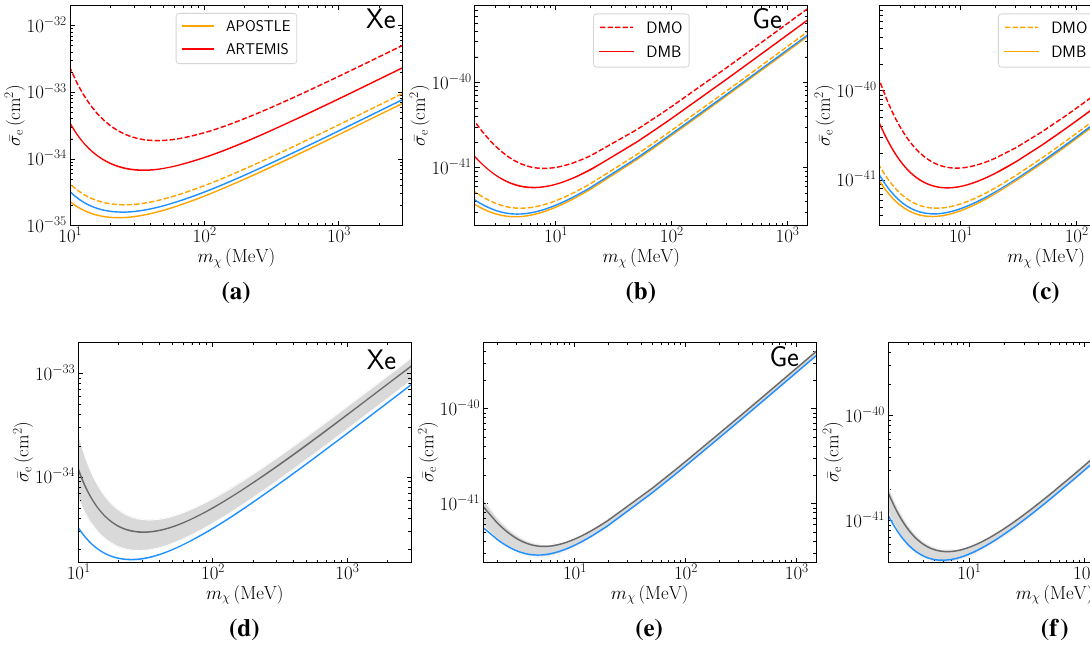
Fig. 10 Same as Fig. 9 but for F DM ∝ q − 2